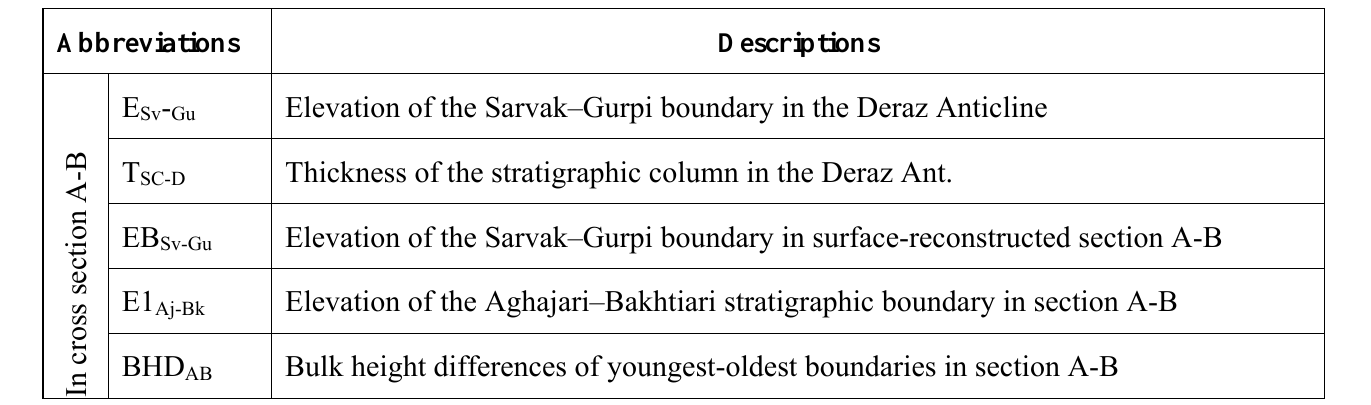
Table 2. The descriptions of abbreviation of different items in the